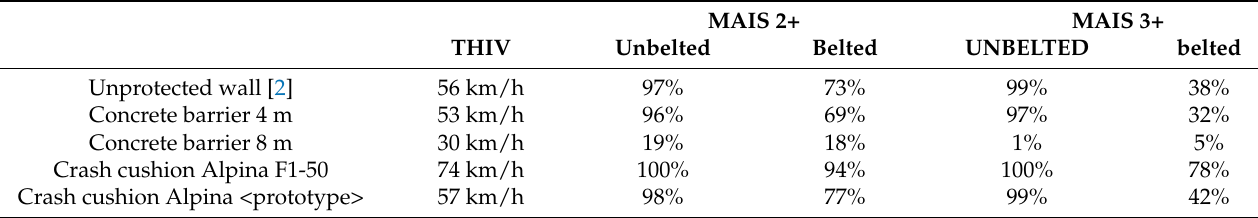
Table 7. Corresponding risk of MAIS 2+ and MAIS 3+ [56] injuries of unbelted and belted occupants related to the ASI of the different safety measur.es